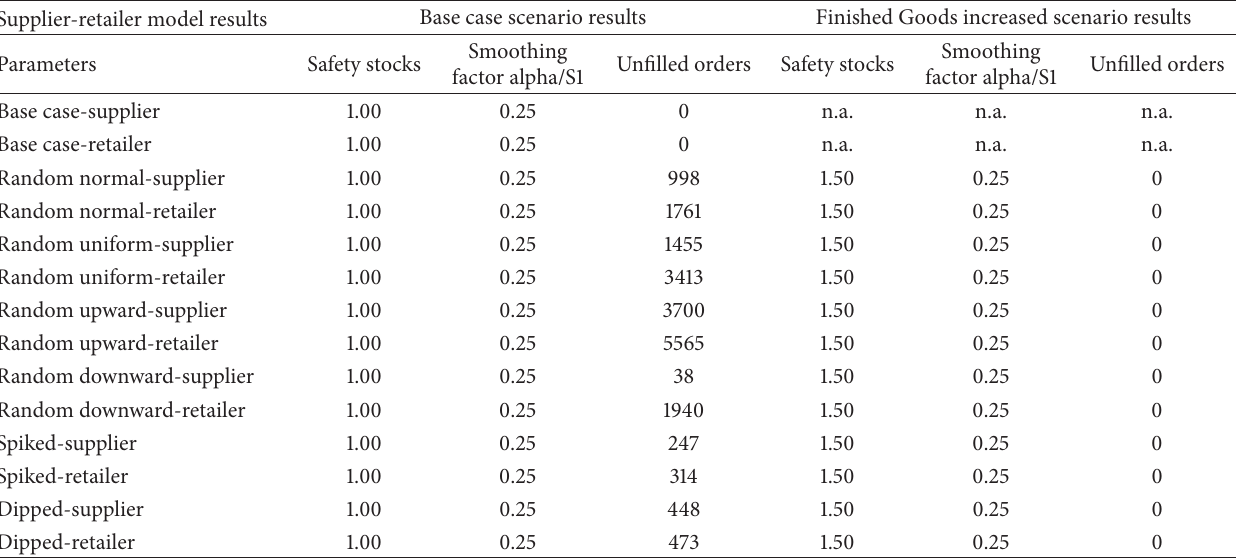
Table 3: Base Case and alternate scenarios without and with increase in Safety stocks.